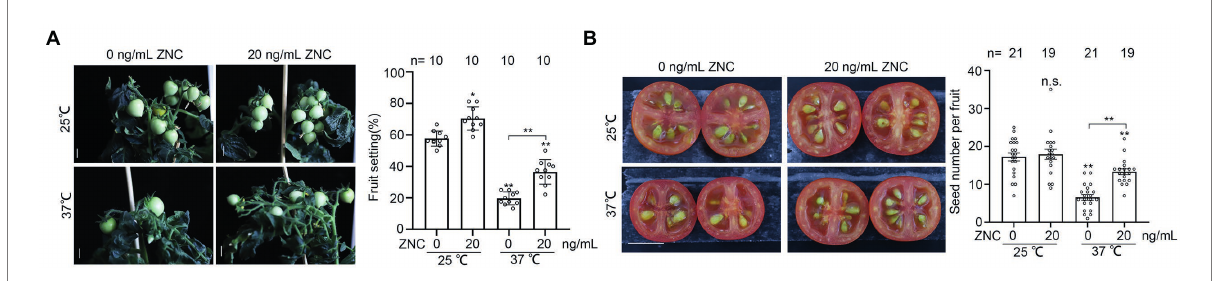
FIGURE 5 ZNC raises fruit and seed bearing under long-term high temperature stress. Plants of 6-week-old were placed under 32 ° C/27 ° C (day/night) until fruits are ripe with or without 20 ng/ml ZNC treatment. (% fruit setting = number of fruits / flowers ×100). (A) Fruit bearing from plants with or without ZNC pretreatment, under long-term treatment at 25 ° C or 37 ° C. (B) Seed set from plants with or without ZNC pretreatment, under long- term treatment at 25 ° C or 37 ° C. n indicates fruit number. Scale bars, 1 cm in A ; 1 cm in A . n indicates the number of tomato plants. Bars represent means ± SE m. Asterisk on the top of data bar indicates significant difference (two-tailed t -test, * p < 0.05, ** p < 0.01) compared with the data bar on the far left, while asterisk above the bracket represents comparison between the two data bars indicated. The symbol n.s. indicates no difference. All experiments have 3 biological replicates and they have similar